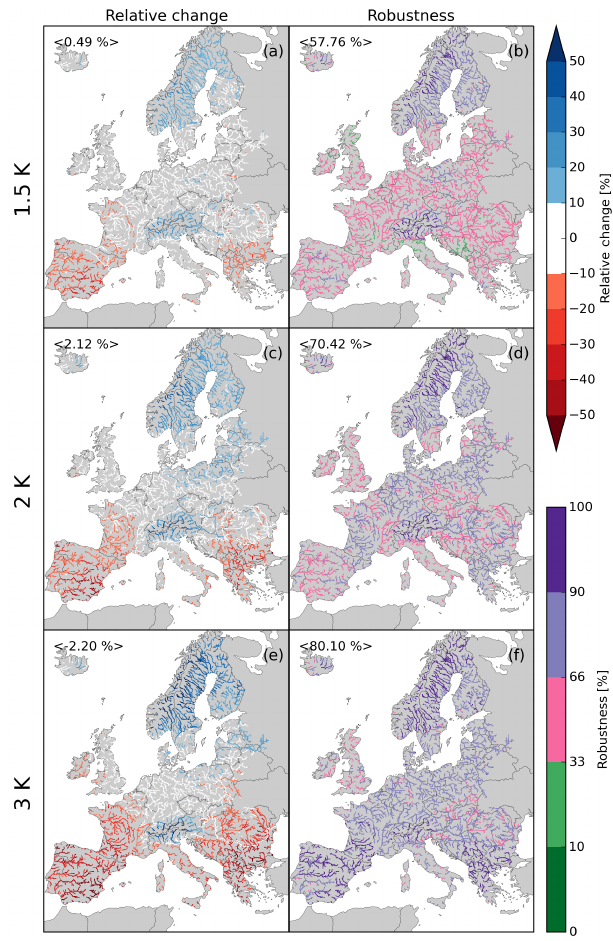
Figure 3. Change in multi-model ensemble mean low flow (%) under different warming levels compared to the 1971–2000 base- line (a, c, e) and robustness (b, d, f) . The latter is expressed by the percentage of simulations based on a Wilcoxon rank-sum test with 5% significance level. An agreement of more than 66% in the ensemble is classified as ”likely” change. The values given in the upper left of the subplots are the continental average along the river network for all grid cells with a contributing area greater than 1000km 2